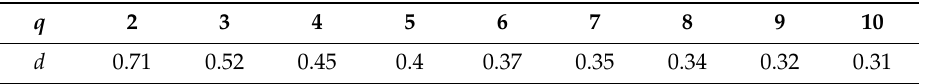
Table 4. Correction coe ffi cients for di ff erent